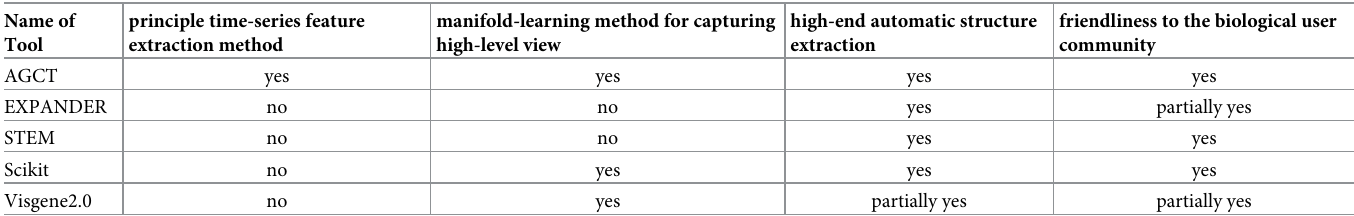
Table 1. The key novelty of